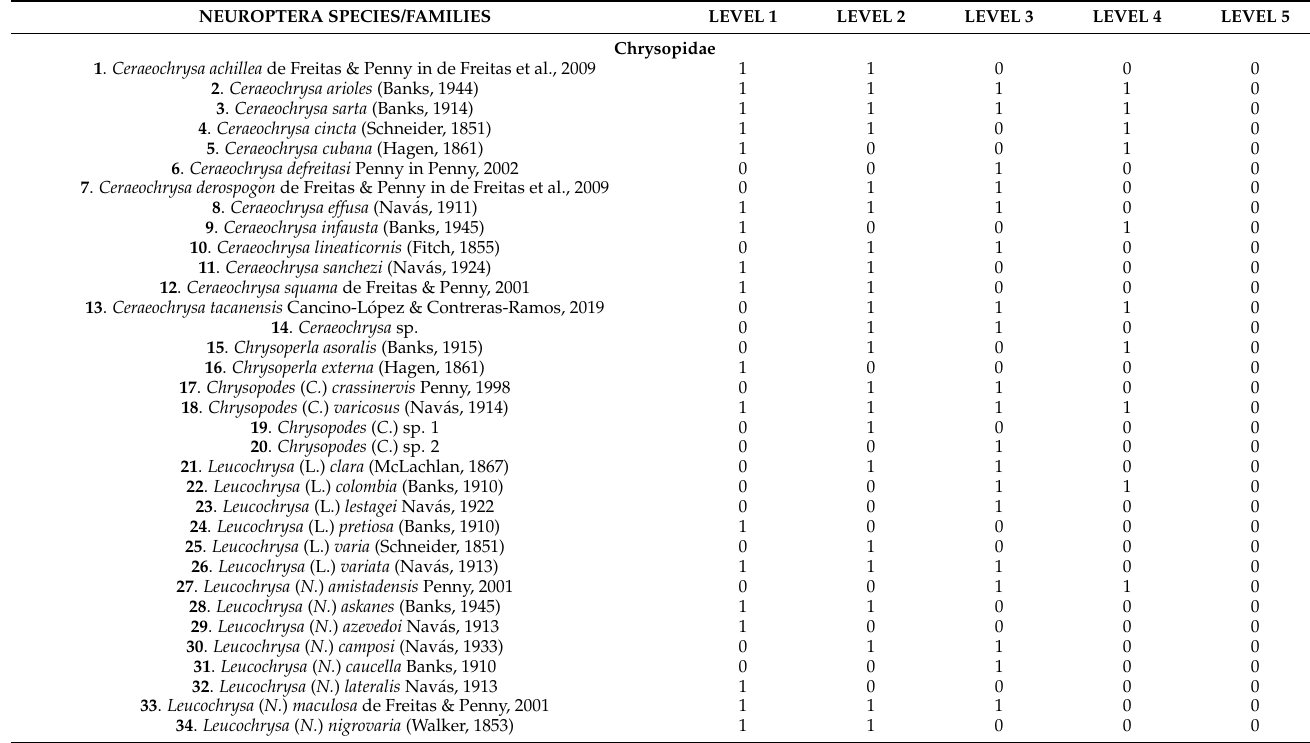
Table A1. Species of Neuroptera from Tacan á volcano, Chiapas, Mexico, distributed by the sampled altitudinal levels. NEUROPTERA